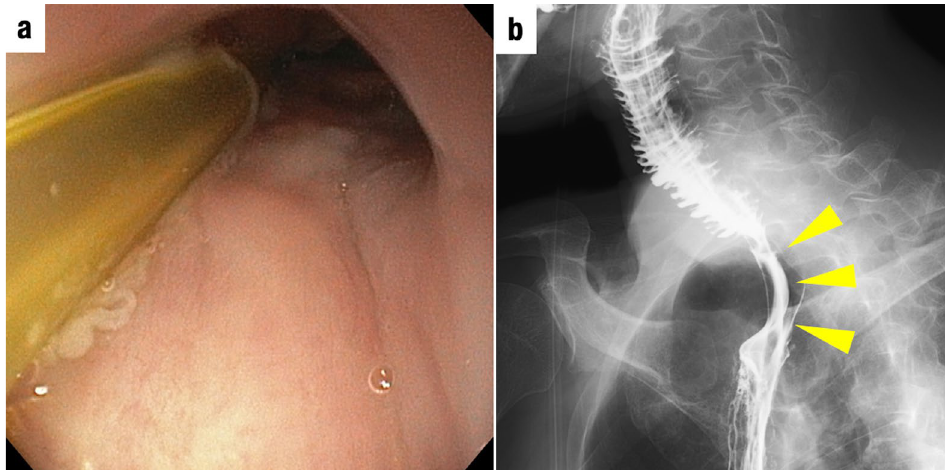
Fig. 4 Postoperative examination. a Upper gastrointestinal endoscopy showing no ischemic changes in the remnant esophagus. b Upper gastrointestinal image showing absence of stenosis and anastomotic leakage in the remnant